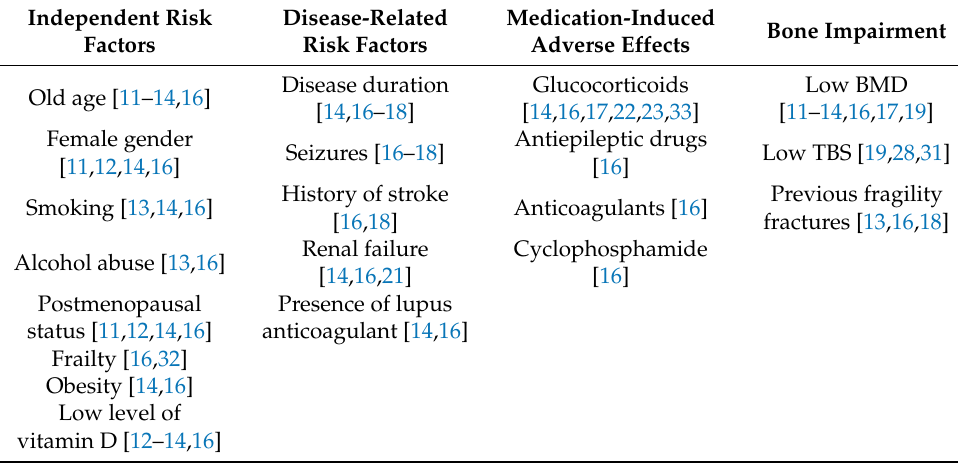
Table 2. Osteoporotic fracture risk factors in